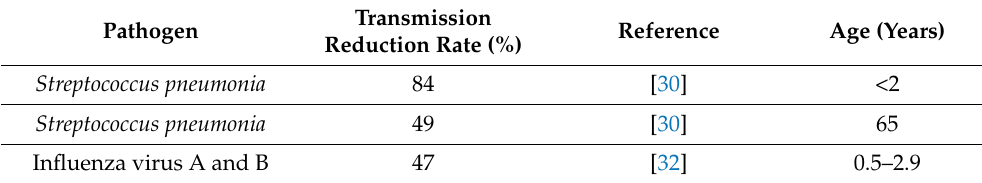
Table 1. Effects of vaccination on the transmission rate of infections in different age groups.